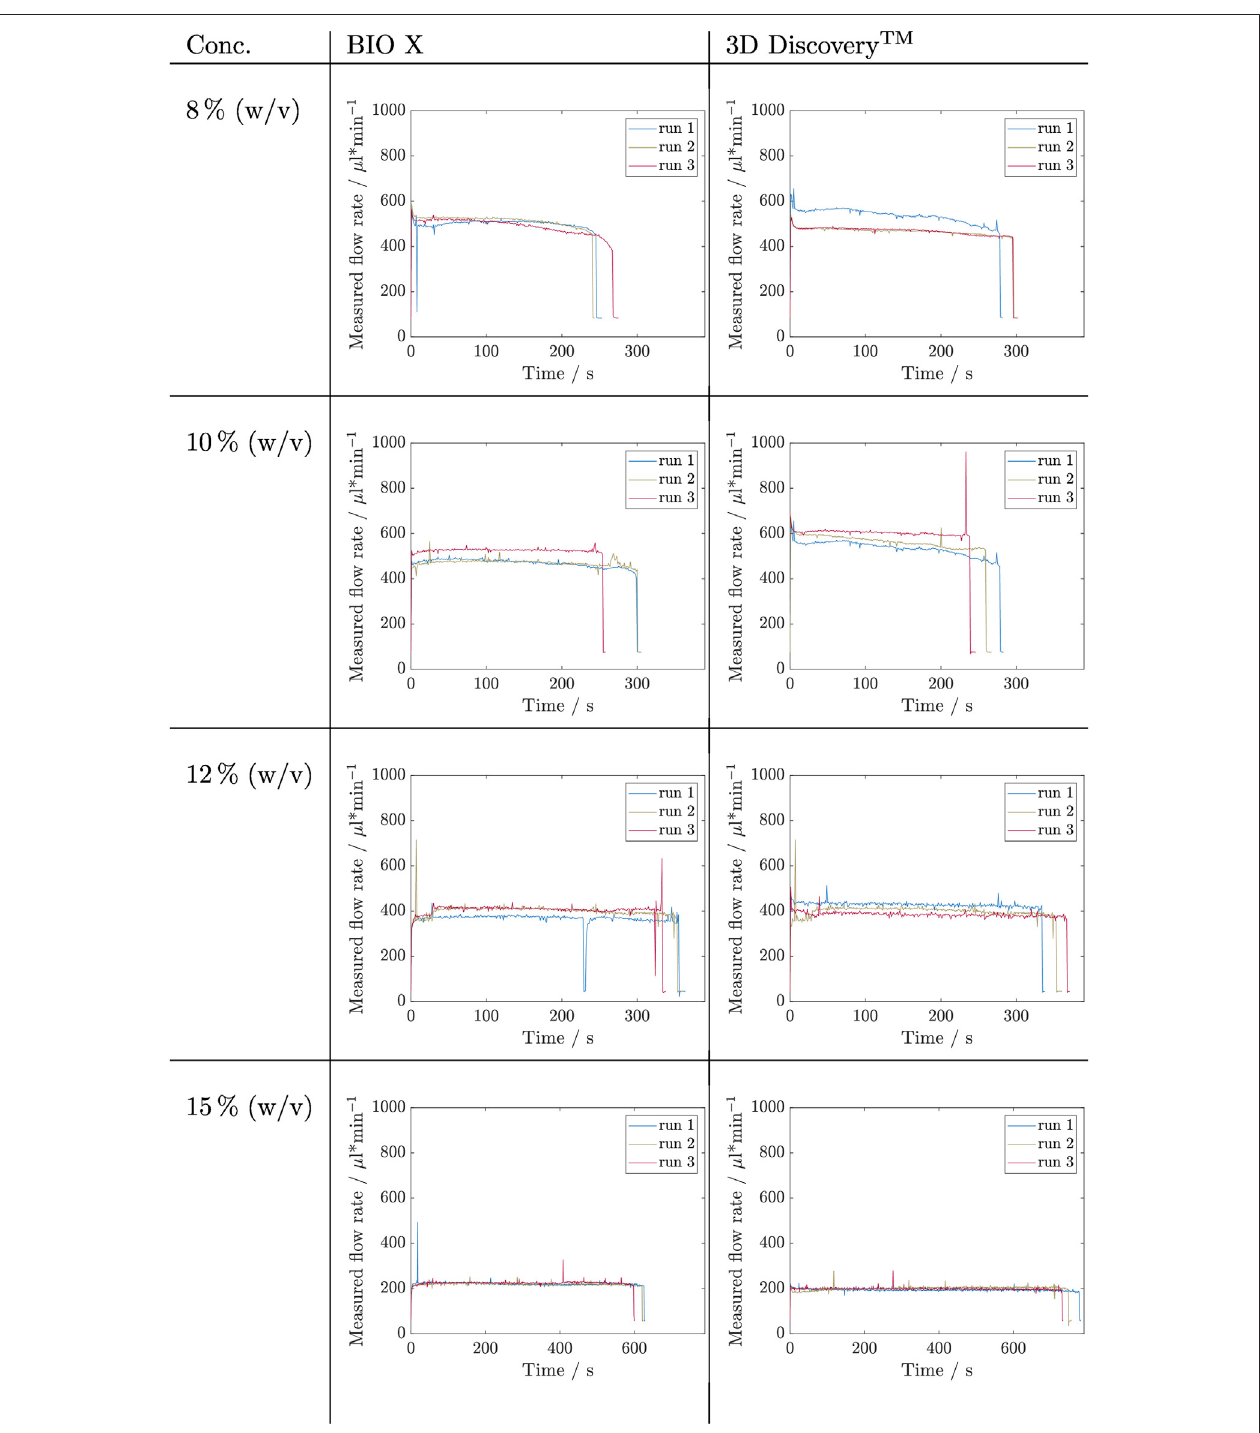
FIGURE6| Resultsof fi llinglevelin fl uenceinvestigationforinkscontainingalginateconcentrationsof8,10,12,and15%(w/v)bymeasuringthe fl owrateduringthe complete emptying of a cartridge. This experiment was carried out in triplicates ( n run = 3) for each concentration and on two bioprinter systems, namely BIOX and 3D Discovery ™ . The respective set pressures are listed in Table 3 .